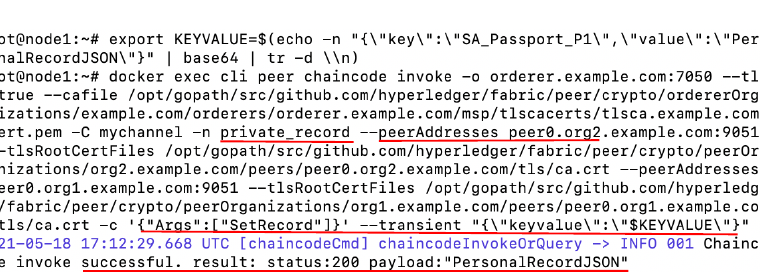
Figure 8. Peer0 of Org2 executes the transaction “SetRecord” to send a private data collection to Org1 with the key=SA_Passport_P1.